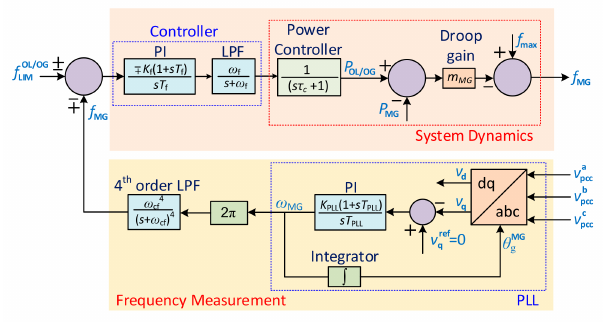
Figure 12. Frequency controller for overload and over-generation prevention.